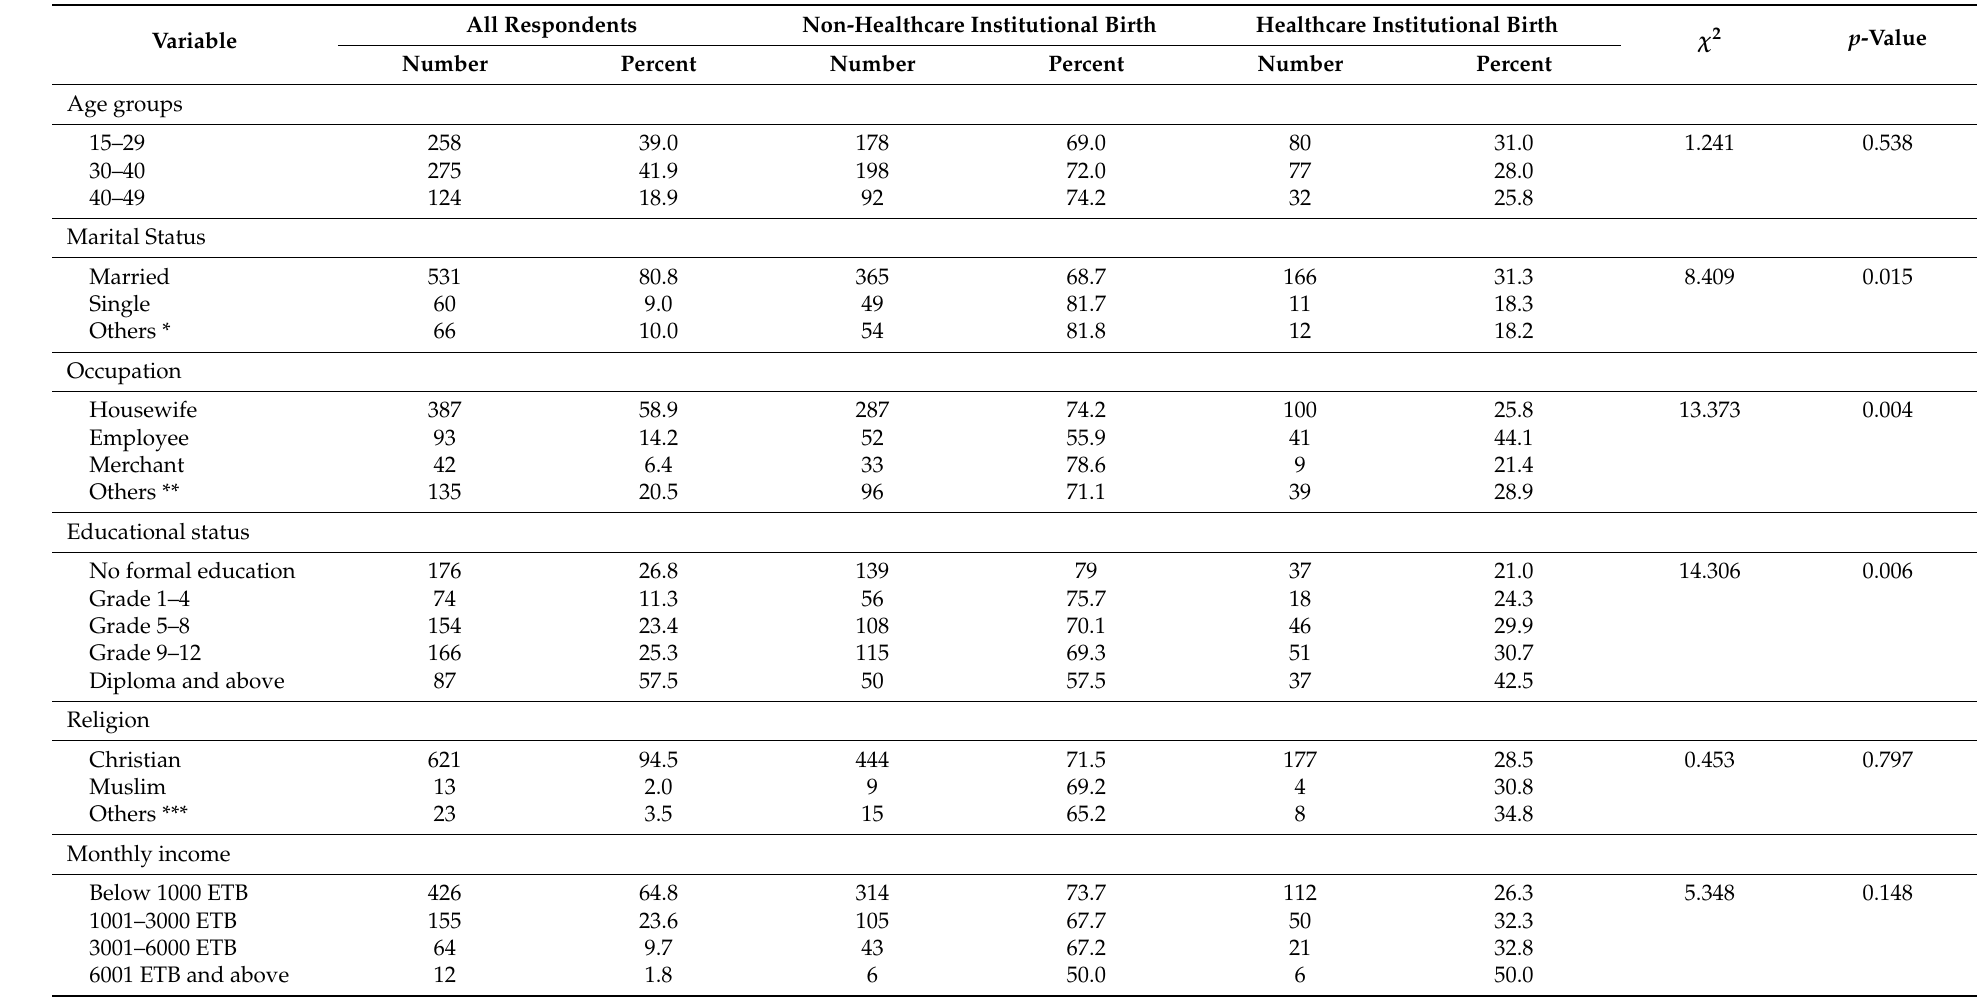
Table 1. Women’s characteristics and association with institutional and non-institutional